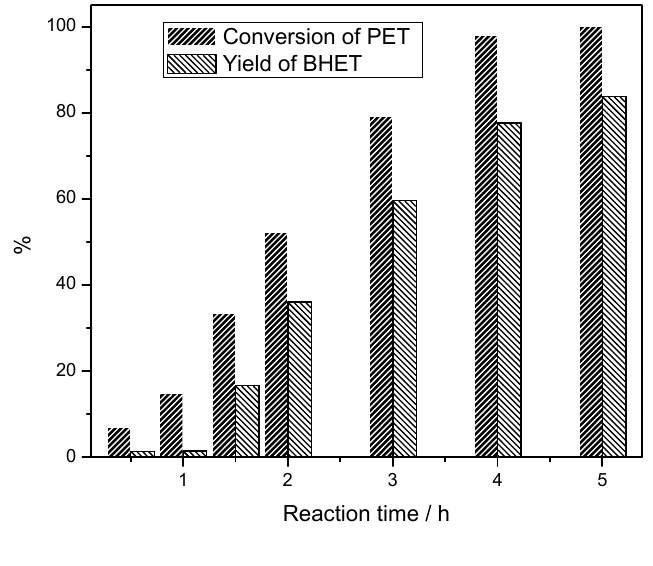
Figure 4. The effects of reaction time on the PET glycolysis with 0.16 wt %